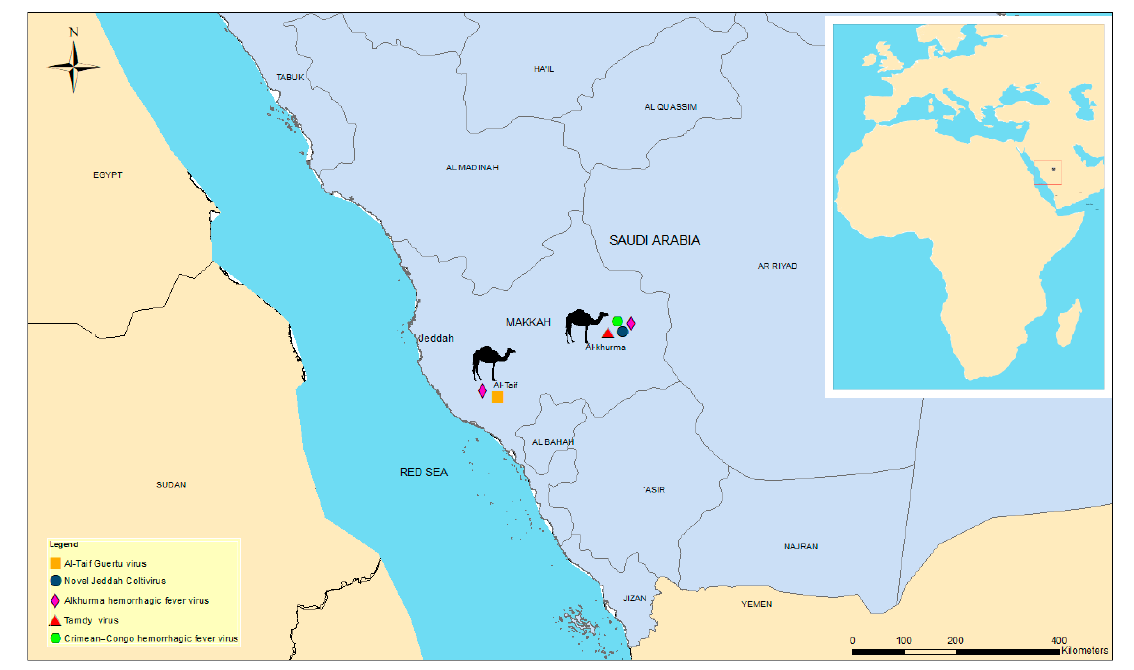
Figure 1. A map of the western part of Saudi Arabia showing the main identified potential pathogens in the province of Makkah.